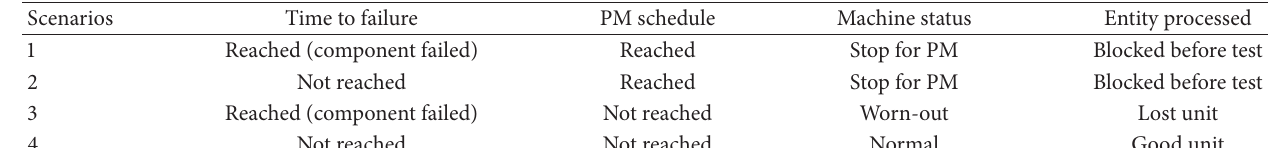
Table 6: Overall scenarios of RCM model.